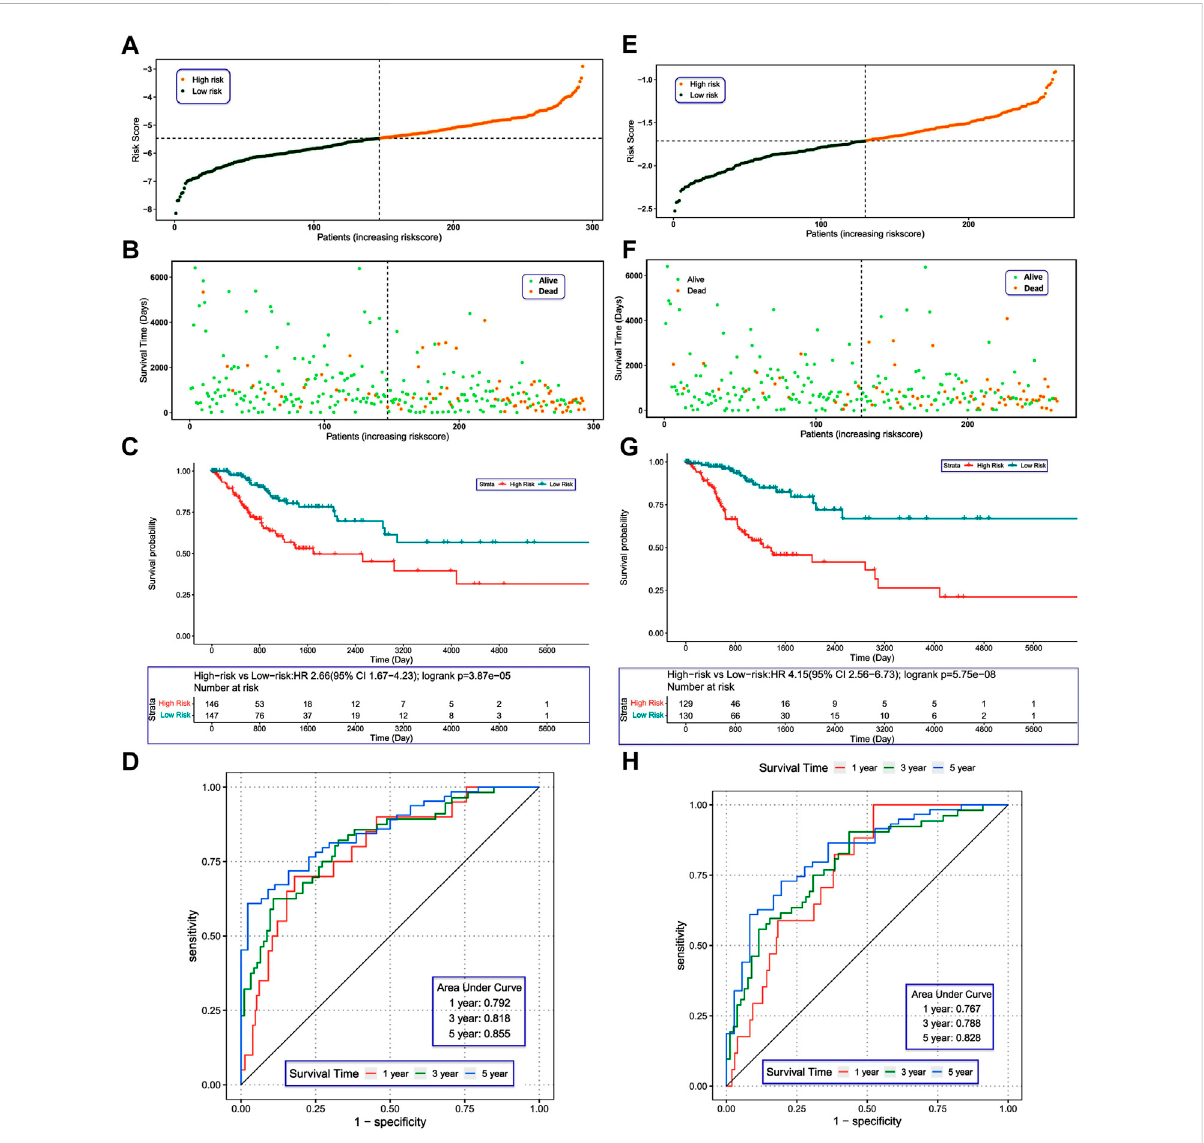
FIGURE 5 (A) Construction and evaluation of a risk model. Distribution of risk scores in the training set. (B) Survival status of patients in the training set. (C) Kaplan – Meierplotofthetrainingset( p < 0.05). (D) Receiveroperatingcharacteristiccurvesshowingthe1-,3-,and5-yearpredictiveef fi ciencyofthe risk score. (E) Distribution of risk scores in the validation set. (F) Survival status of patients in the validation set. (G) Kaplan – Meier plot of the validation set ( p < 0.05). (H) The area under the receiver operating characteristic curves in the validation set for 1-, 3-, and 5-year